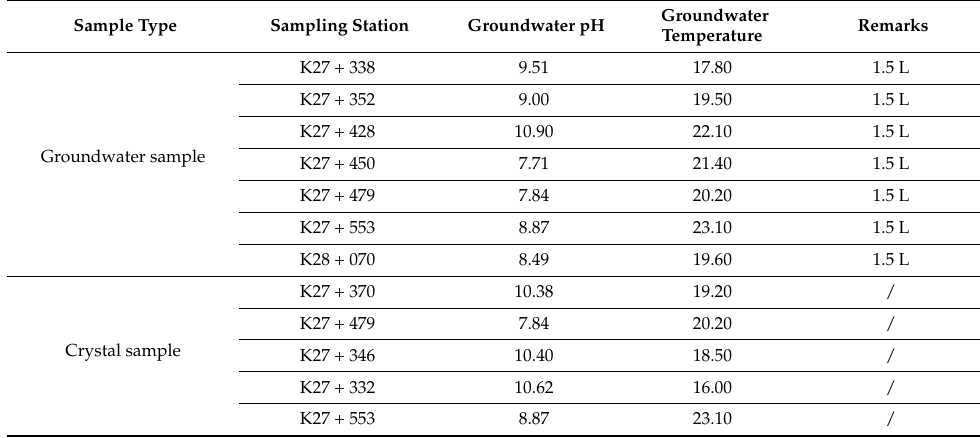
Figure 3. Field sampling. ( a ) water sample; ( b ) crystal sample. Table 1. Site sampling locations and tests.